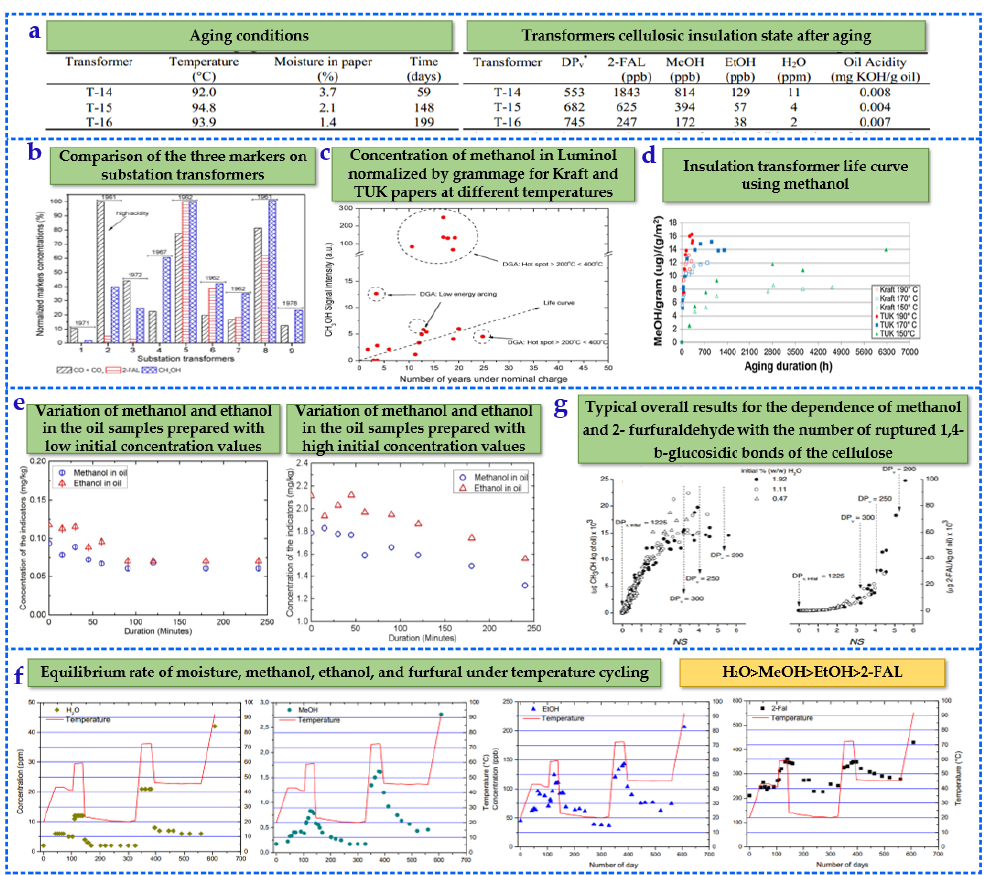
Figure 7. Summary of the basis for methanol and ethanol as chemical indicators of cellulose degra- dation. ( a ) experimental conditions for the detection of methanol and ethanol, ( b ) comparison of CO+CO 2 , furfural and methanol content in field transformers, ( c ) the relationship between the normalized concentration of methanol and the temperature for different types of insulating paper, ( d ) variation of methanol concentration with time under multivariate laboratory conditions, ( e ) rela- tionship between methanol and ethanol and aging time, ( f ) comparison of the stability of moisture, methanol, ethanol and furfural, ( g ) association of methanol with cellulosic 1,4- β glycosidic bonds.